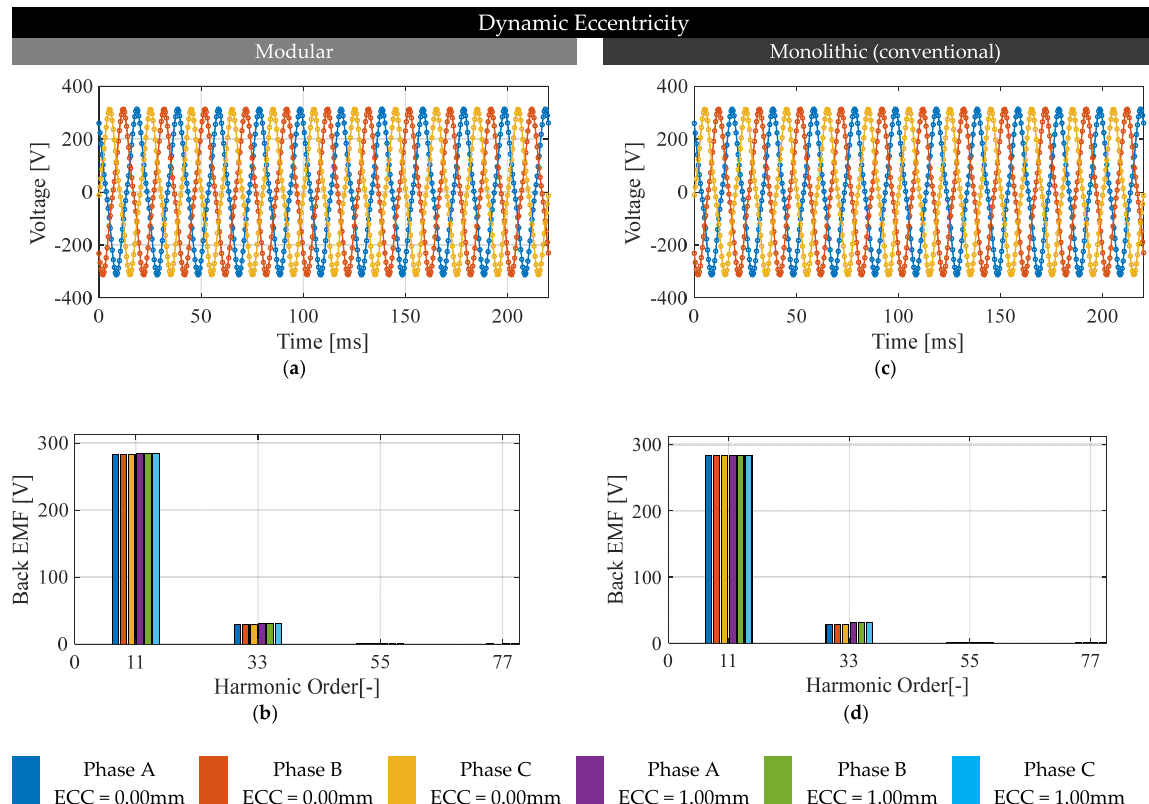
Figure 8. FE evaluation of the back-emf in the presence of DE for a 24-slot, 22-pole PMSM and MPMSM: ( a ) back-emf waveform for the modular machine, ( b ) back-emf spectrum for the modular machine, ( c ) back-emf waveform for the monolithic machine, ( d ) back-emf spectrum for the monolithic machine.